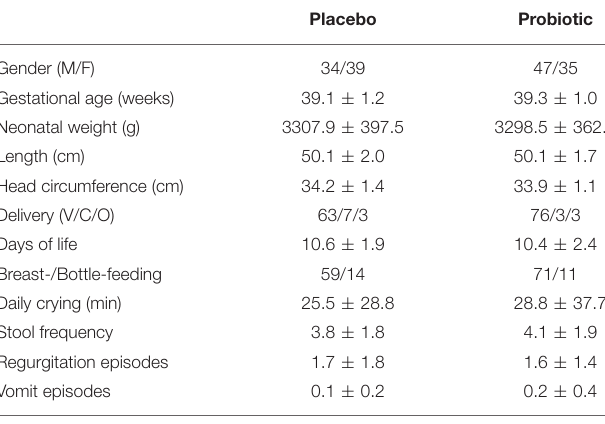
TABLE 3 | Auxological characteristics of the whole cohort at baseline (T0) according to the allocation treatment.